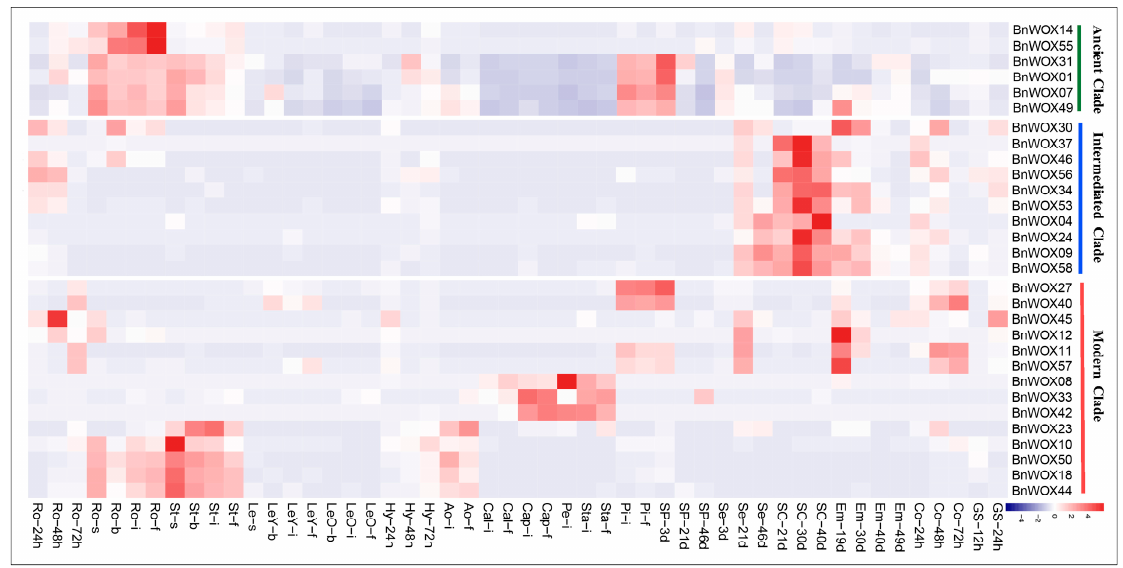
Figure 6. Patterns of BnWOX gene expression in different tissues during plant development. In the color bar at the lower right side of the figure, blue represents little or no expression, and red represents a high level of expression. Ro = root, St = stem, Le = leaf, Sp = silique pericarp, Sc = seed coat, Em = embryo, Ao = anthocaulus, Se = seed, Hy = hypocotyl, GS = germinating seed, Cap = capillament, Pi = pistil, Cal = calyx, Co = cotyledon and Pe = petal; h, d, s, b, i and f indicate hour, day, seeding, budding, initial flowering and full-bloom stages, respectively. BnWOX s with no or weak expression (FPKM < 1) were removed and the remaining family members were clustered by